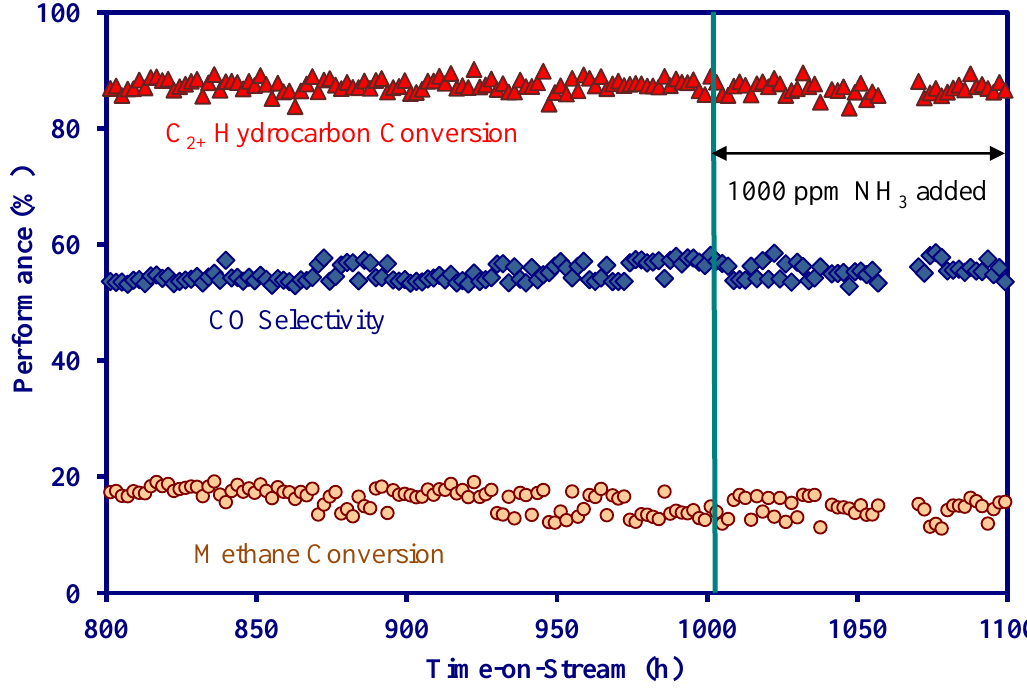
Figure 8. Reforming of biomass gasification products on MNS-washcoated cordierite monolith in the presence of NH GHSV = 10,000 h −1 , 14.4% H 44.6% H O, 1.6% C 2 22 ppm H 2